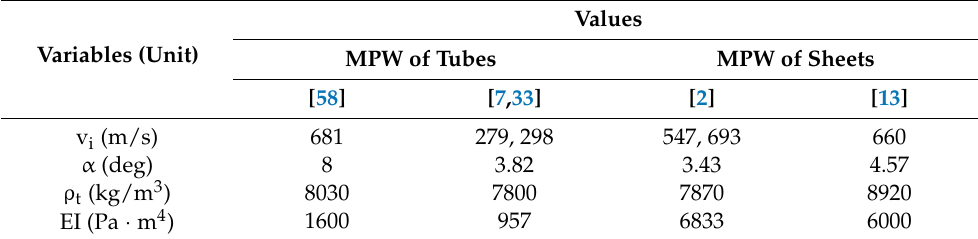
Table 8. Values used for the calculation of the joint length (W L ).